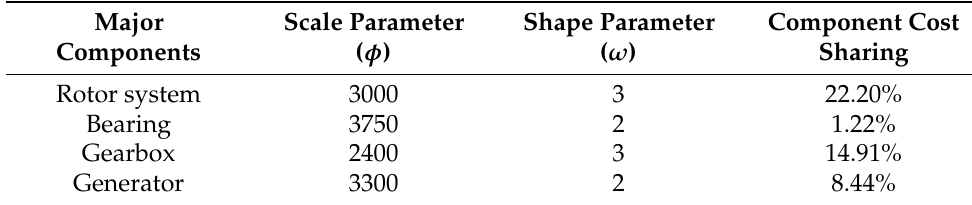
Table 3 lists the cost data of the main components. Table 3. The parameters of the four main components.